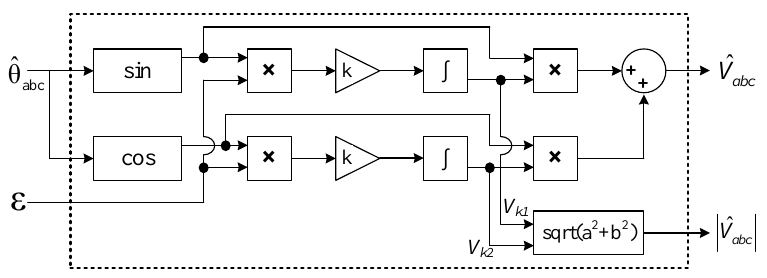
Figure 6. Block diagram of the fundamental estimation function.